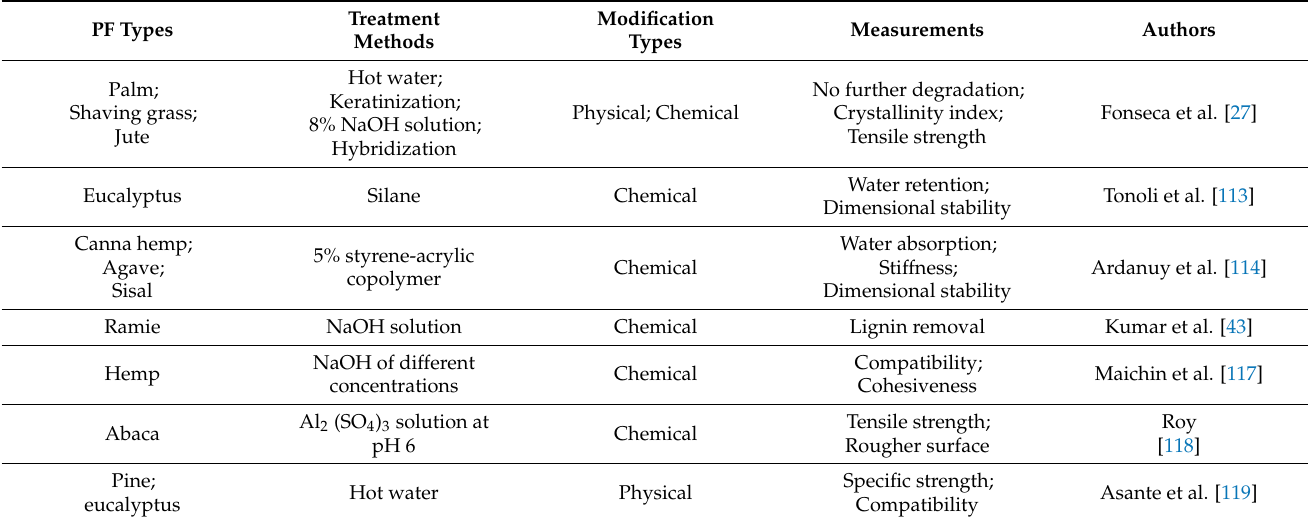
Table 4. Summary of the treatment techniques of